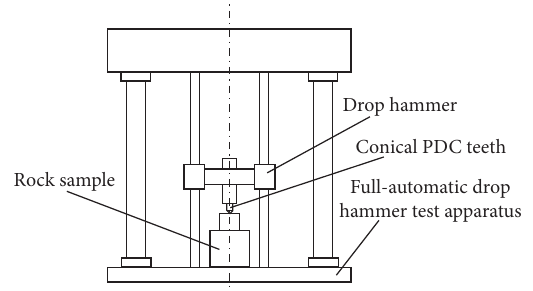
Figure 4: Schematic graph for the impact